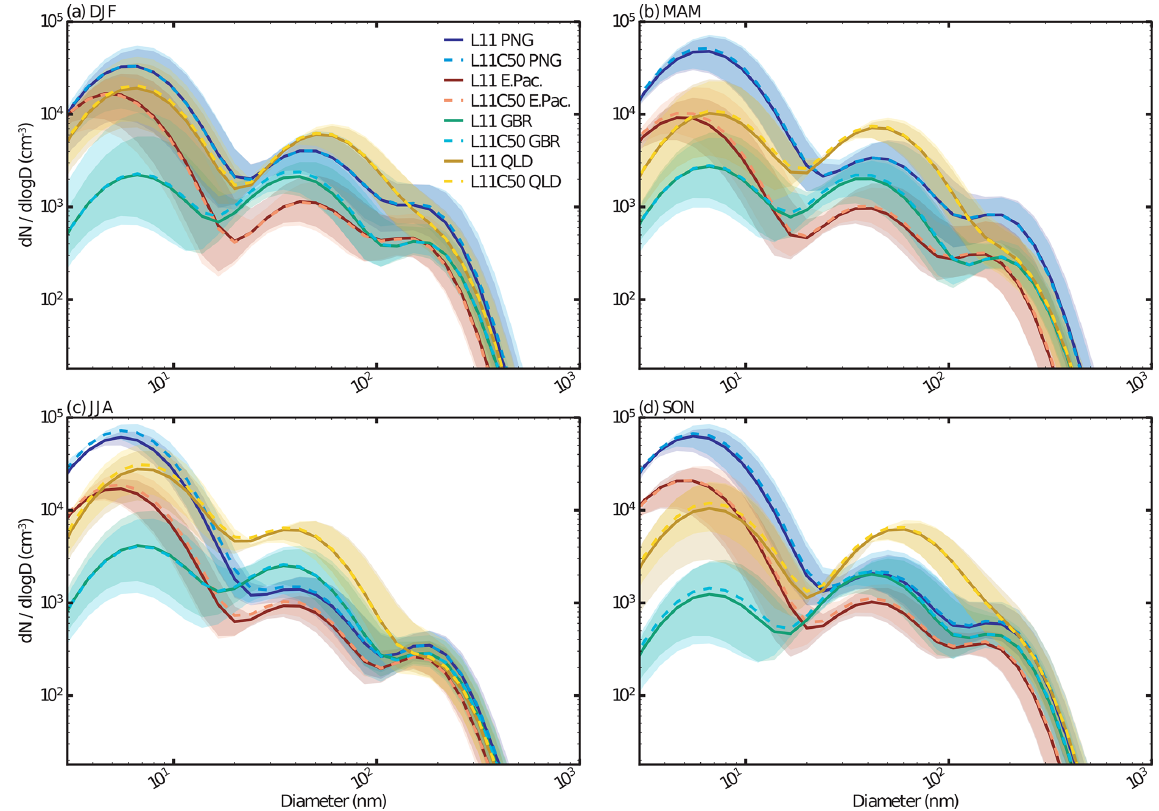
Figure 7. Aerosol dry diameter in nanometres (nm, x axis) and number concentration (as a function of number over the log of the diameter) in cubic centimetres (cm − 3 , y axis), both in log scales, for four regions: off the coast of PNG (blues), in the East Pacific (reds/oranges), over the GBR (green/turquoise) and inland QLD (yellow/brown), for the L11C50 (dashed lines) and L11 simulations (solid lines) (see Fig. 1b for regions), for four seasons: DJF (a) , MAM (b) , JJA (c) and SON (d) . The lines show the ensemble mean for the free-running simulations, and the shaded regions show the range of results from all years in the